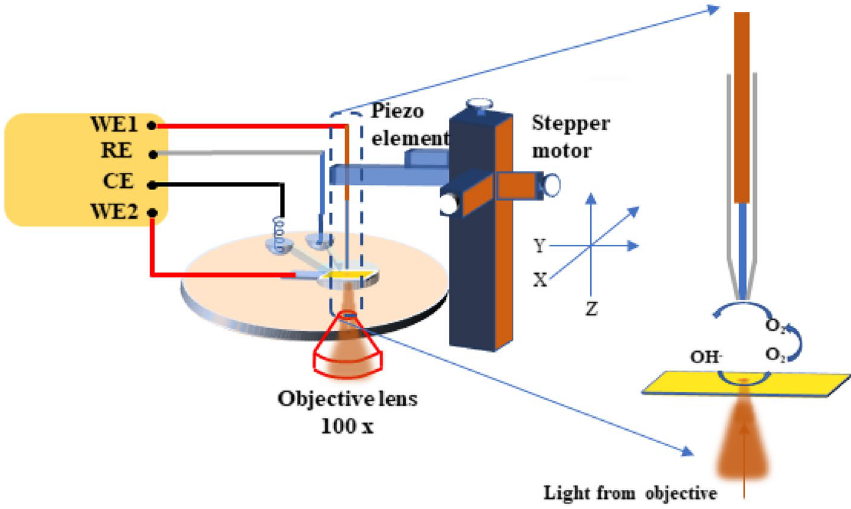
Figure 1. Schematic illustration of SECM setup and zoomed part of α-Fe 2 O 3 substrate and microelectrode showing photoelectrochemical and oxygen reduction reaction, respectively.